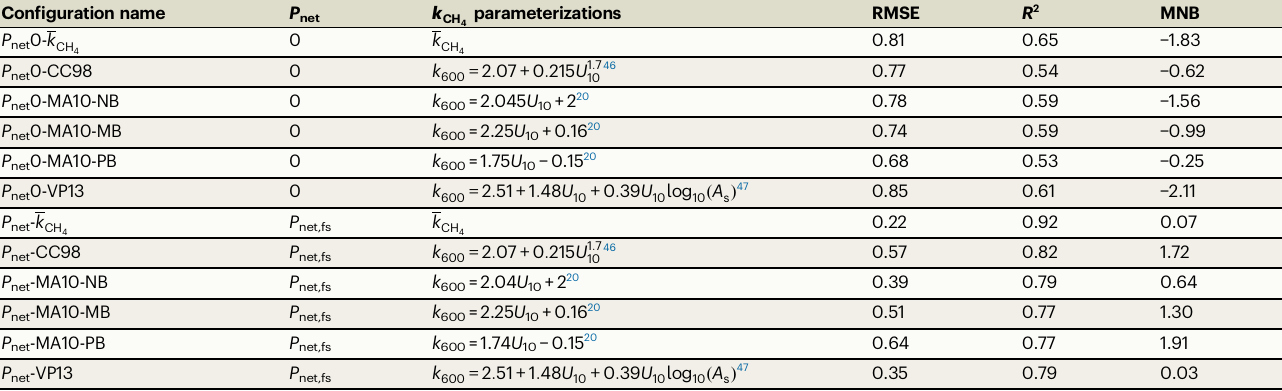
Table 3 | Results of the sensitivity analysis of the use of fi ve literature mass transfer coef fi cients ( k CH 4 production ( P net ), to simulate the CH 4 concentrations using the lateral transport model Con fi guration name